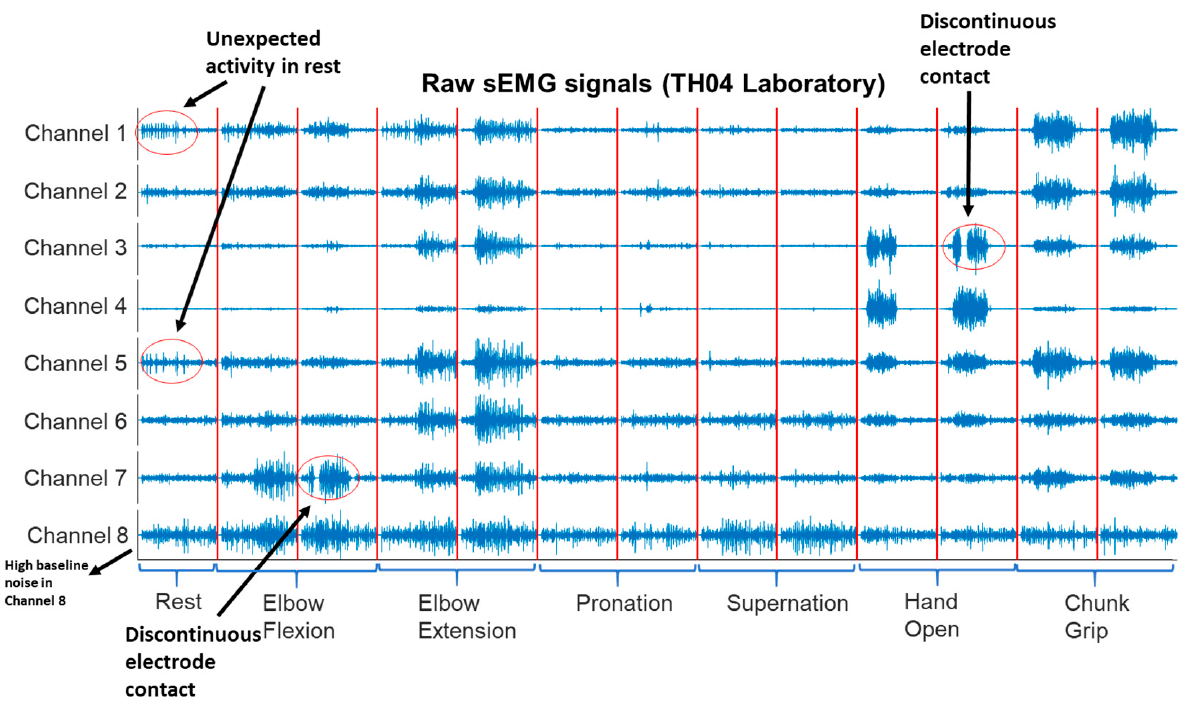
Figure 5. An example of laboratory sEMG signals with signal noise and user timing issues.